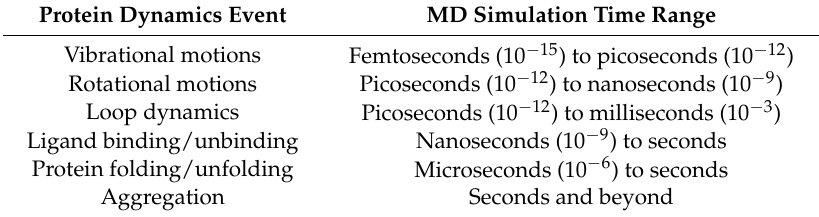
Figure 3. A schematic of the molecular dynamics process. Table 2. The typical molecular dynamics (MD) simulations timescales that can observe various protein dynamics